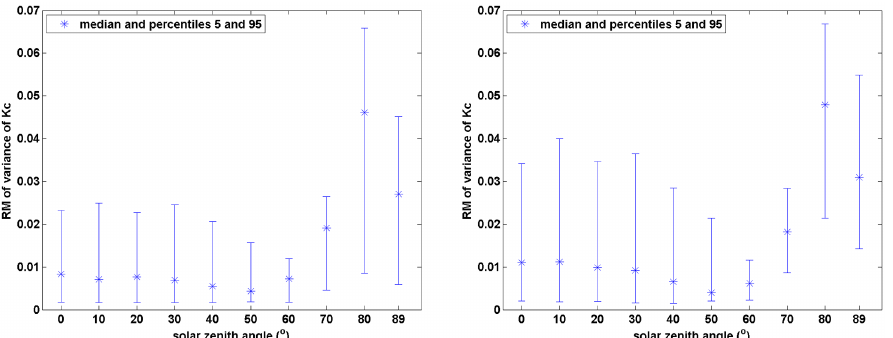
Figure 3. Median (star) and 5th and 95th percentiles of RM (v(K c )) for all couples ( ρ g , τ c ) as a function of θ S for water cloud (left) and ice cloud